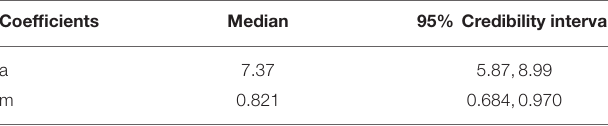
TABLE 1 | Median and 95% credibility intervals of the a and m parameters describing the colour discrimination function of a violet sensitive bird to a set of 20 different quasi monochromatic stimuli from 470 to 670